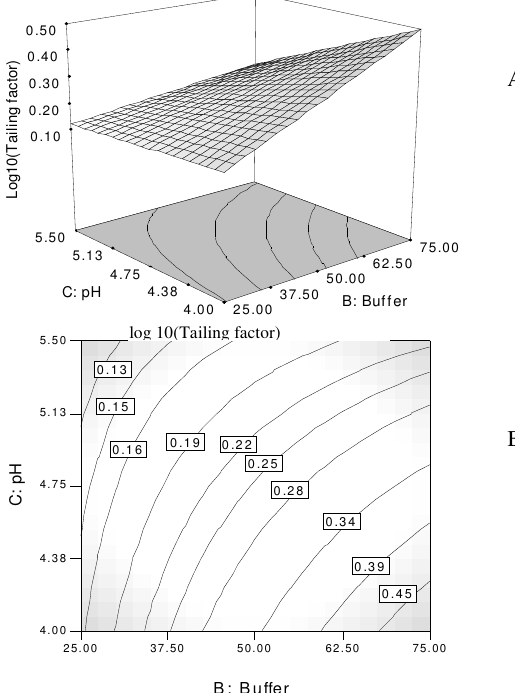
Figure 5( A ). 3-D plot and (B) Contour plot showing the influence of proportion of buffer in the mobile phase and the pH of the mobile phase on the Log